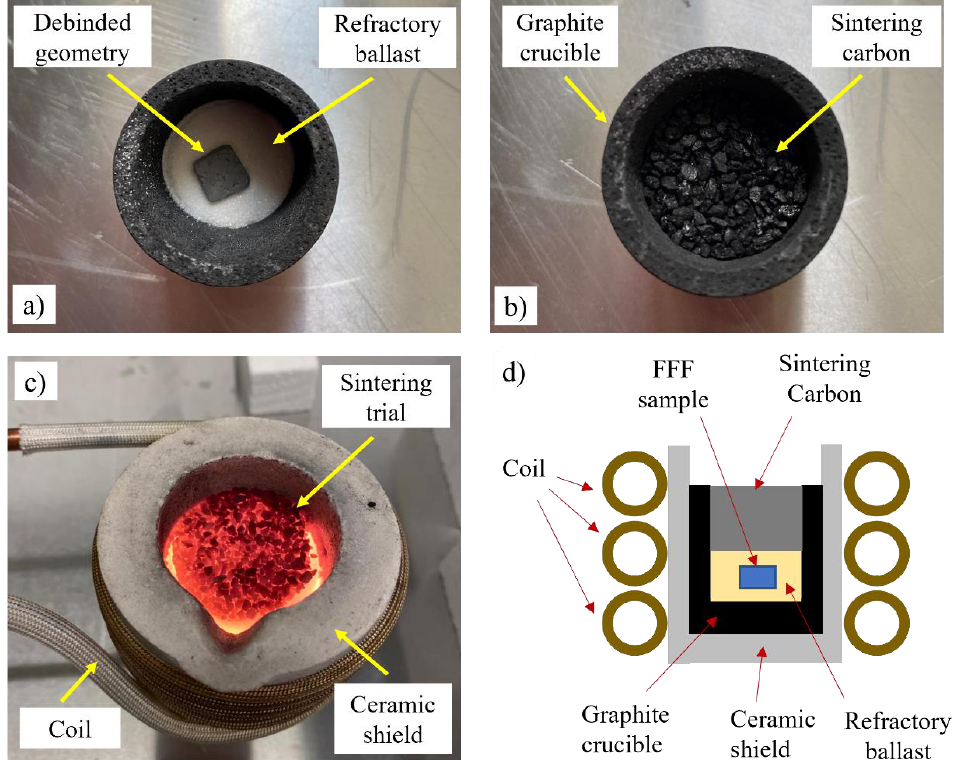
Figure 5. Indirect induction sintering setup with ( a ) the debinded geometry partially buried in the refractory ballast, ( b ) graphite crucible with a top layer of carbon pellets, ( c ) treatment in operation, and ( d ) illustration of the test.